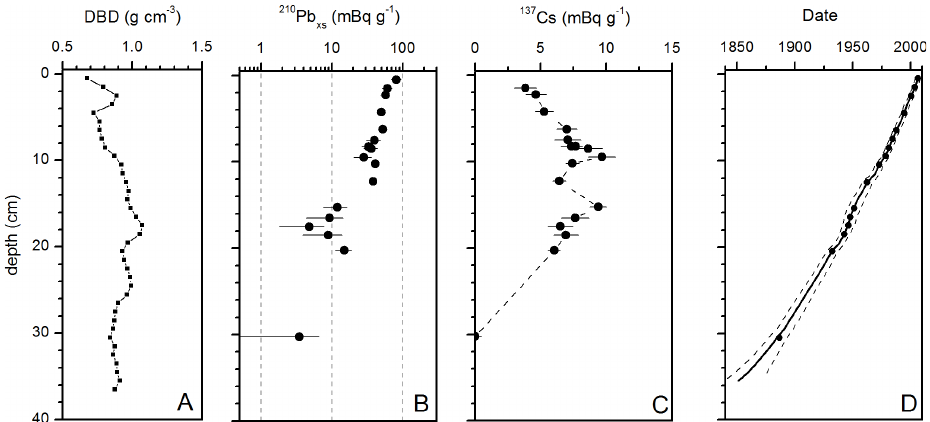
Fig. 3. Dry bulk density (A) , 210 Pbxs (B) , 137 Cs profiles (C) and ages of sedimentary 1032 layers, based on CRS model, (D) with depth in core